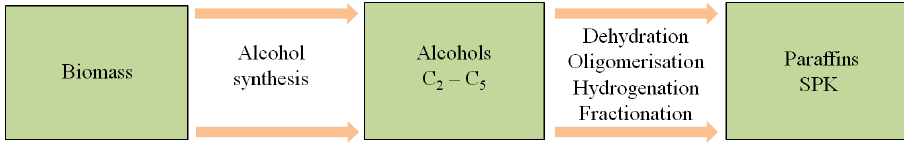
Table 3. Engine test matrix Test Number